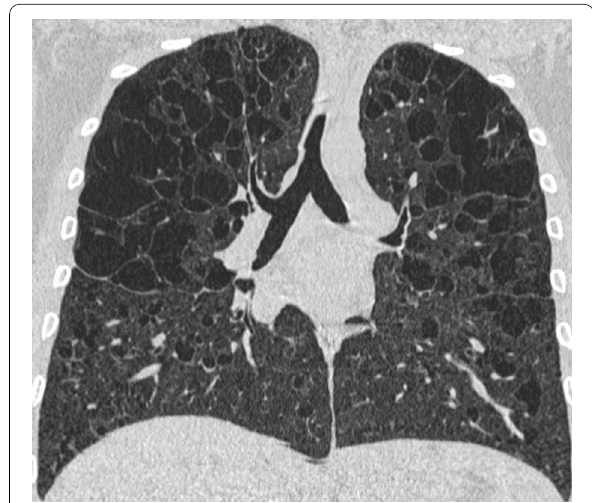
Fig. 6 A known case of Langerhans cell histiocytosis in a 16-year-old male with chronic progressive dyspnea showing bilateral, bizarrely shaped, thin wall cysts predominantly in the upper lobe and nodules; estimated CT score was 5